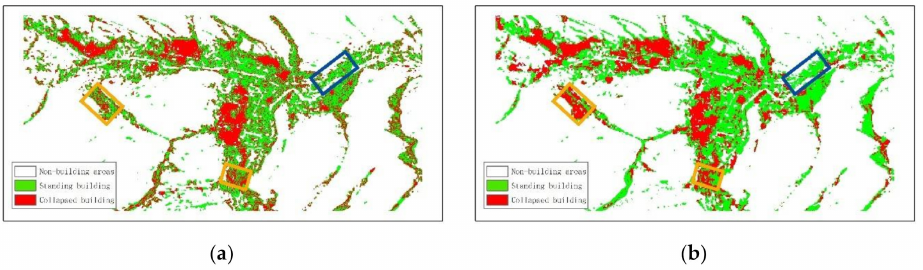
Figure 24. The classification results of collapsed and standing buildings in the Yushu study site: ( a ) only using the feature MaxC; ( b ) using the feature MaxC and eight GLCM texture features together. However, we can also note that only using the feature MaxC is not enough. The areas highlighted by the yellow rectangles in Figure 24a were seriously damaged areas in reality.